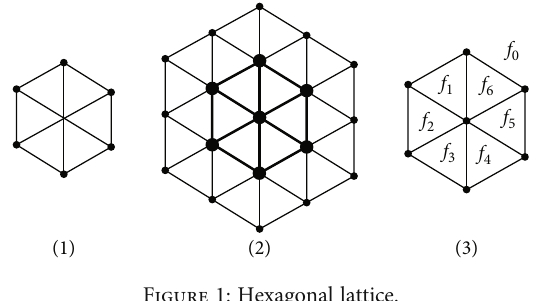
Figure 1: Hexagonal